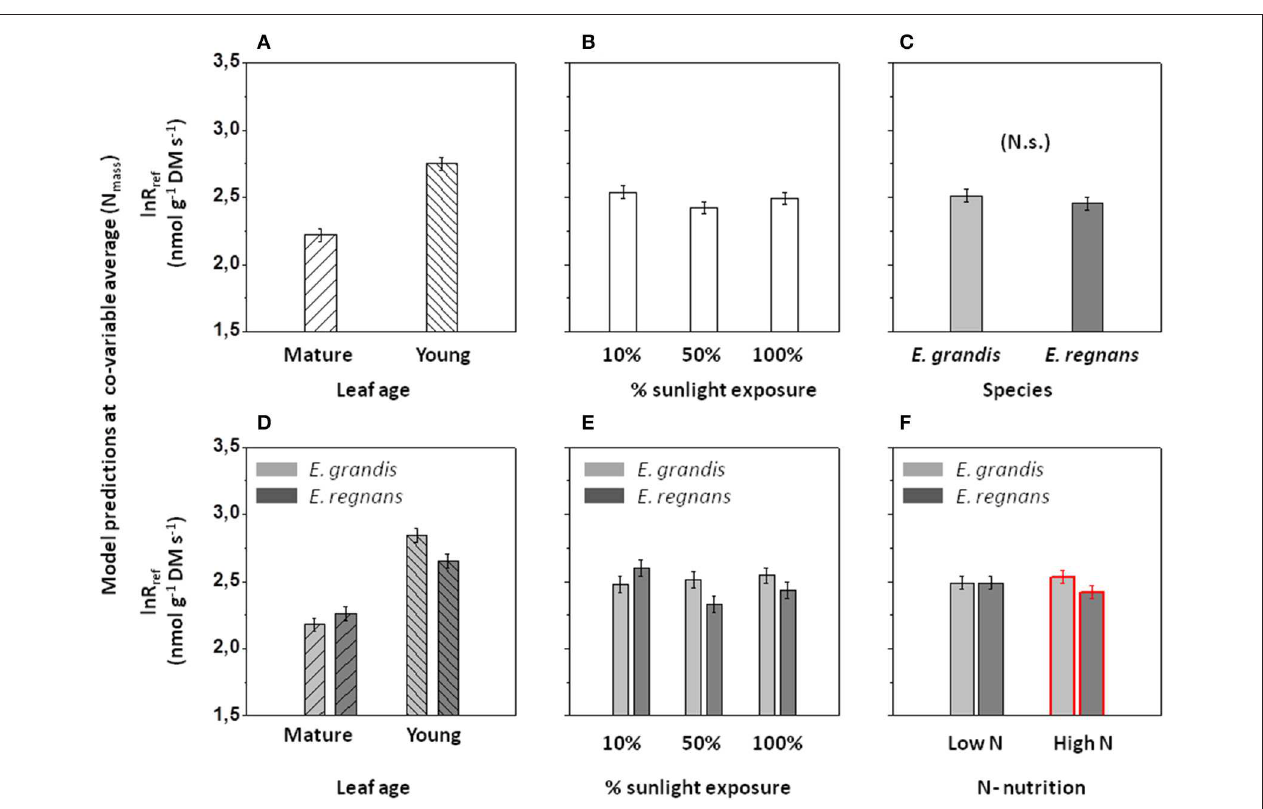
FIGURE 8 | Effects of categorical predictor variables on respiratory capacity (lnR ref ), after accounting for the linear dependency on foliar N mass as co-variable in ANCOVA. (A) Species-dependent effect. (B) Leaf age-dependent effect. (C) Effect of growth irradiance. (D) Interactive effect between species and leaf age. (E) Interactive effect between species and growth irradiance. (F) Interactive effect between species and nitrogen nutrition. Values shown are predicted capacities of mitochondrial oxygen reduction (i.e., lnR ref ) within ± 95% confidence intervals at the co-variable average (i.e., N mass = 16.5mg g − 1 DM). For further information on effect sizes on lnR ref in ANCOVA, see Table 4A